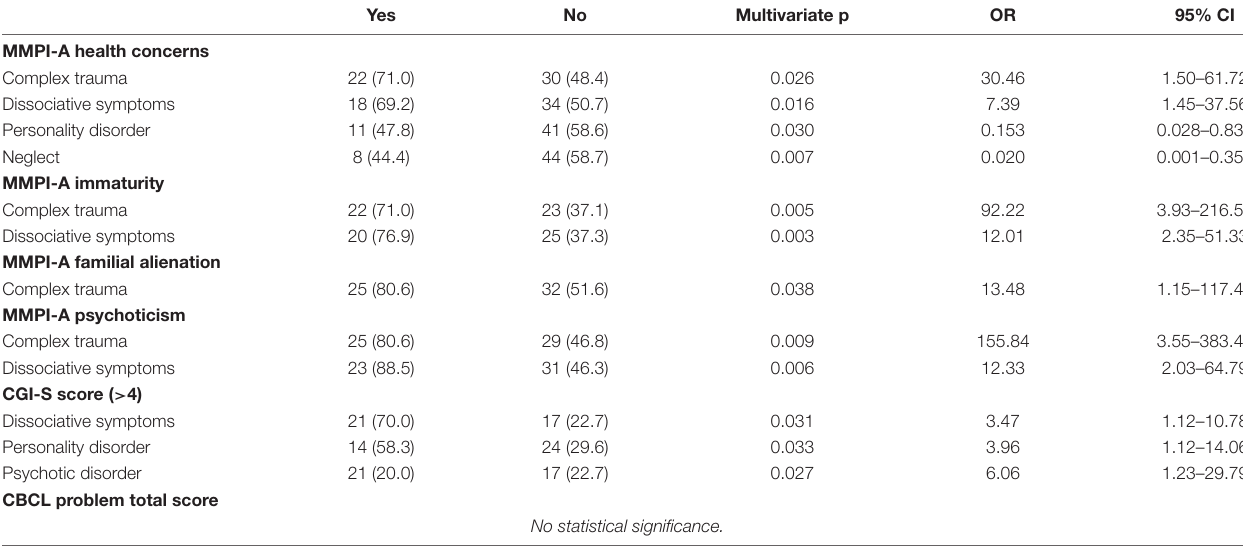
TABLE 3 | Variables associated with MMPI-A Factors and CGI-S scores in multivariate logistic linear regression. Yes No Multivariate p OR 95%